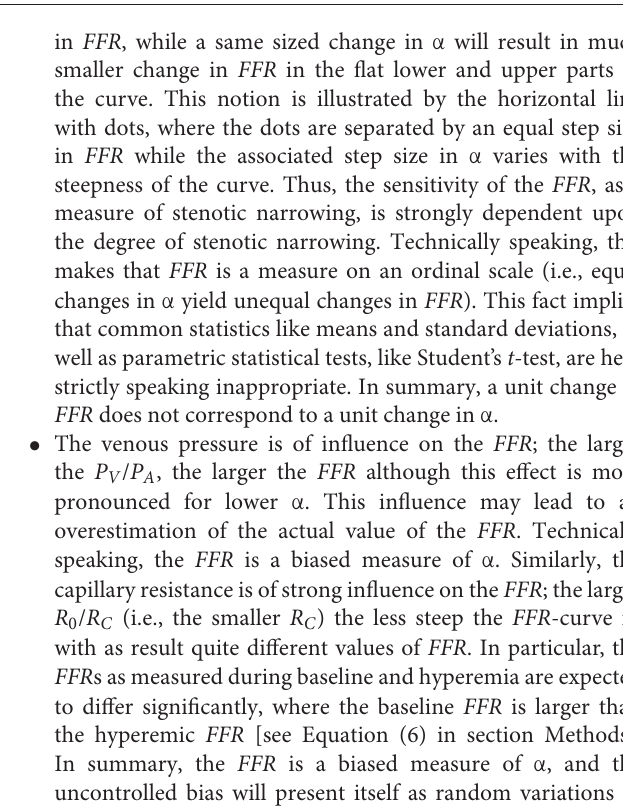
FIGURE 3 | Simulation results for the non-linear dependence of: • the FFR with common reference values at 0.75 and 0.8 (upper-left panel), • its companion FFR C (upper-right panel), • the distal-to-stenosis pressure P D (lower-left panel), to the degree of stenosis α ( α 1 is no stenosis, α 0 means complete occlusion) for different values of R 0 / R C and P V / P A (see legend). = = • The relation of FFR as function of P D (lower-right panel), (The legend in upper-left panel applies also to the upper-right and lower-left panel). See section Results for details.